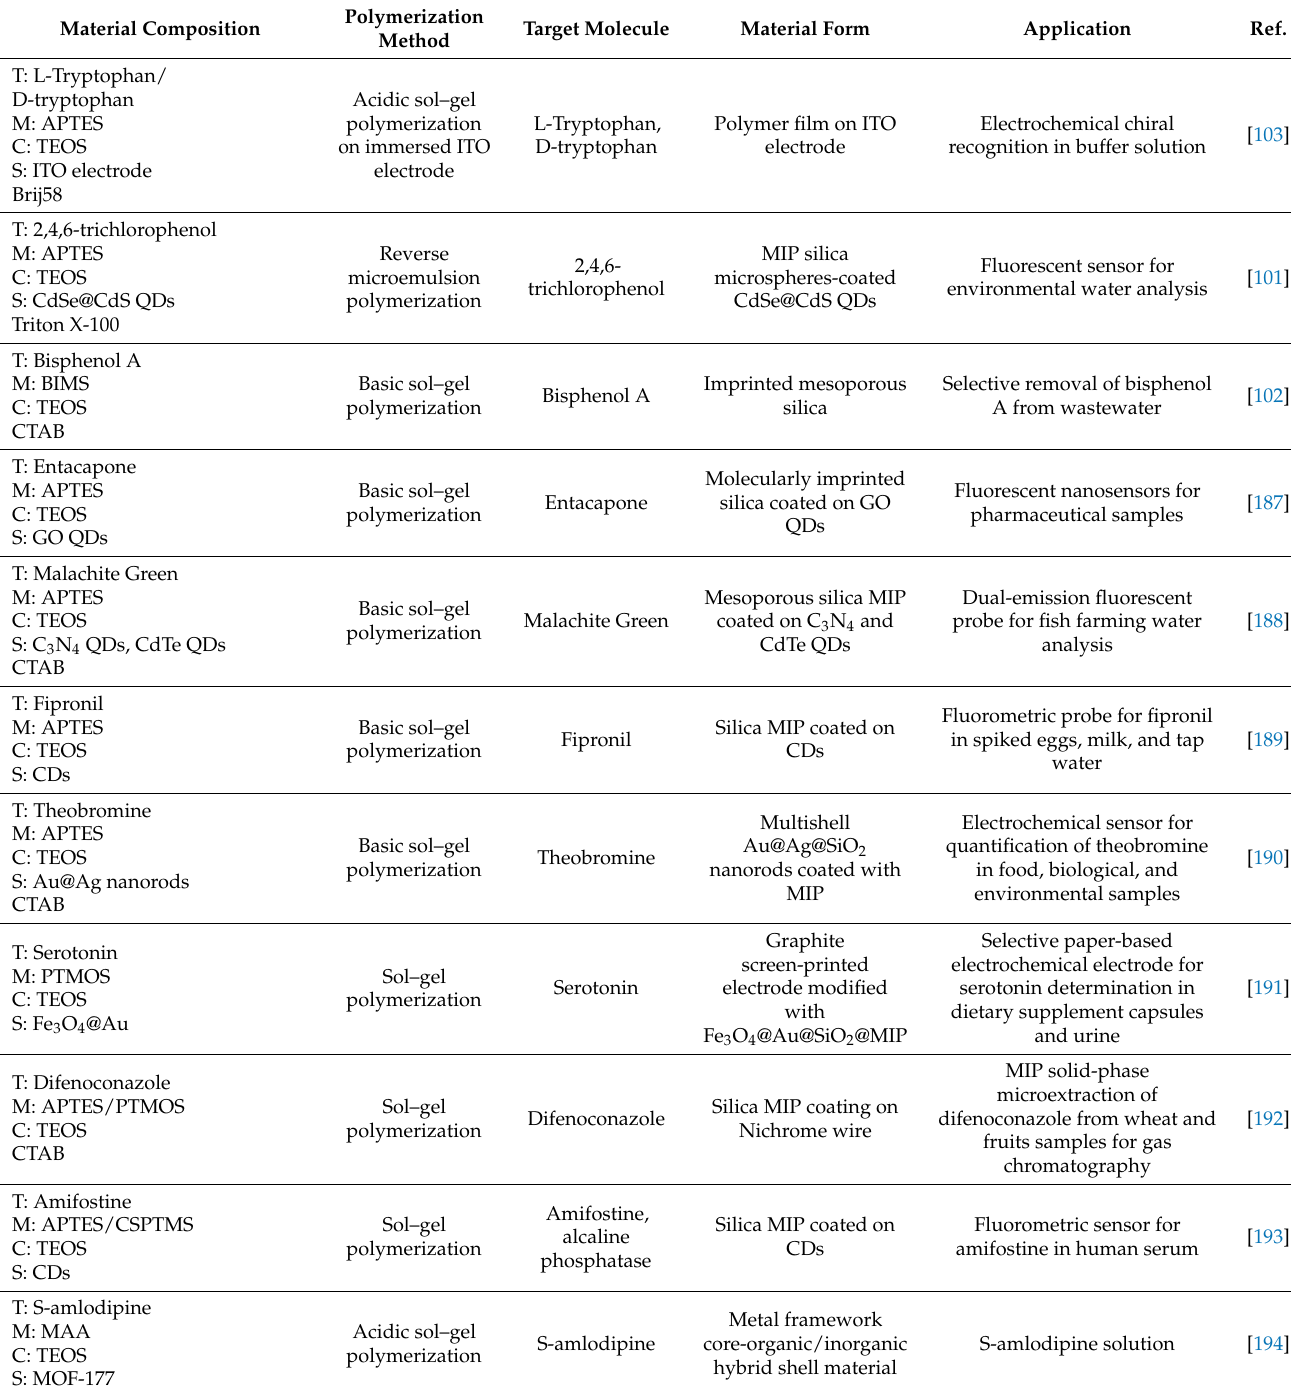
Table 1. Recent examples of siloxane-based imprinted materials, compositions, polymerization methods, target molecules, material forms, and